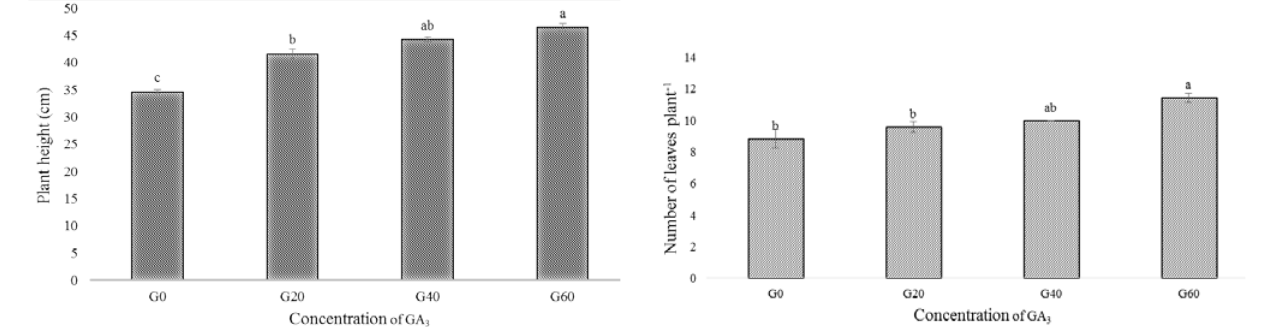
on the number of leaves at 3